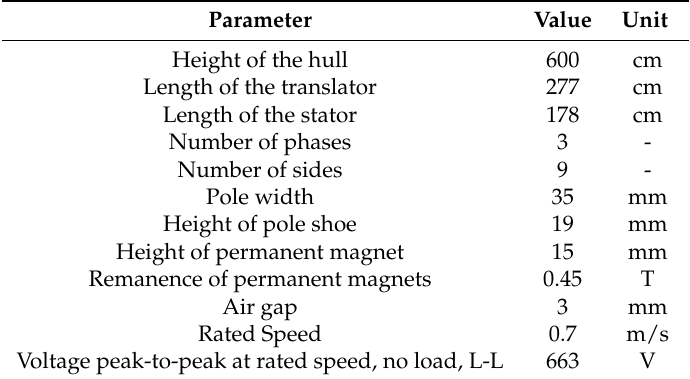
Table 1. Generator parameters for the L12 used during the onshore tests. Description of the first L12 can be found in [33].